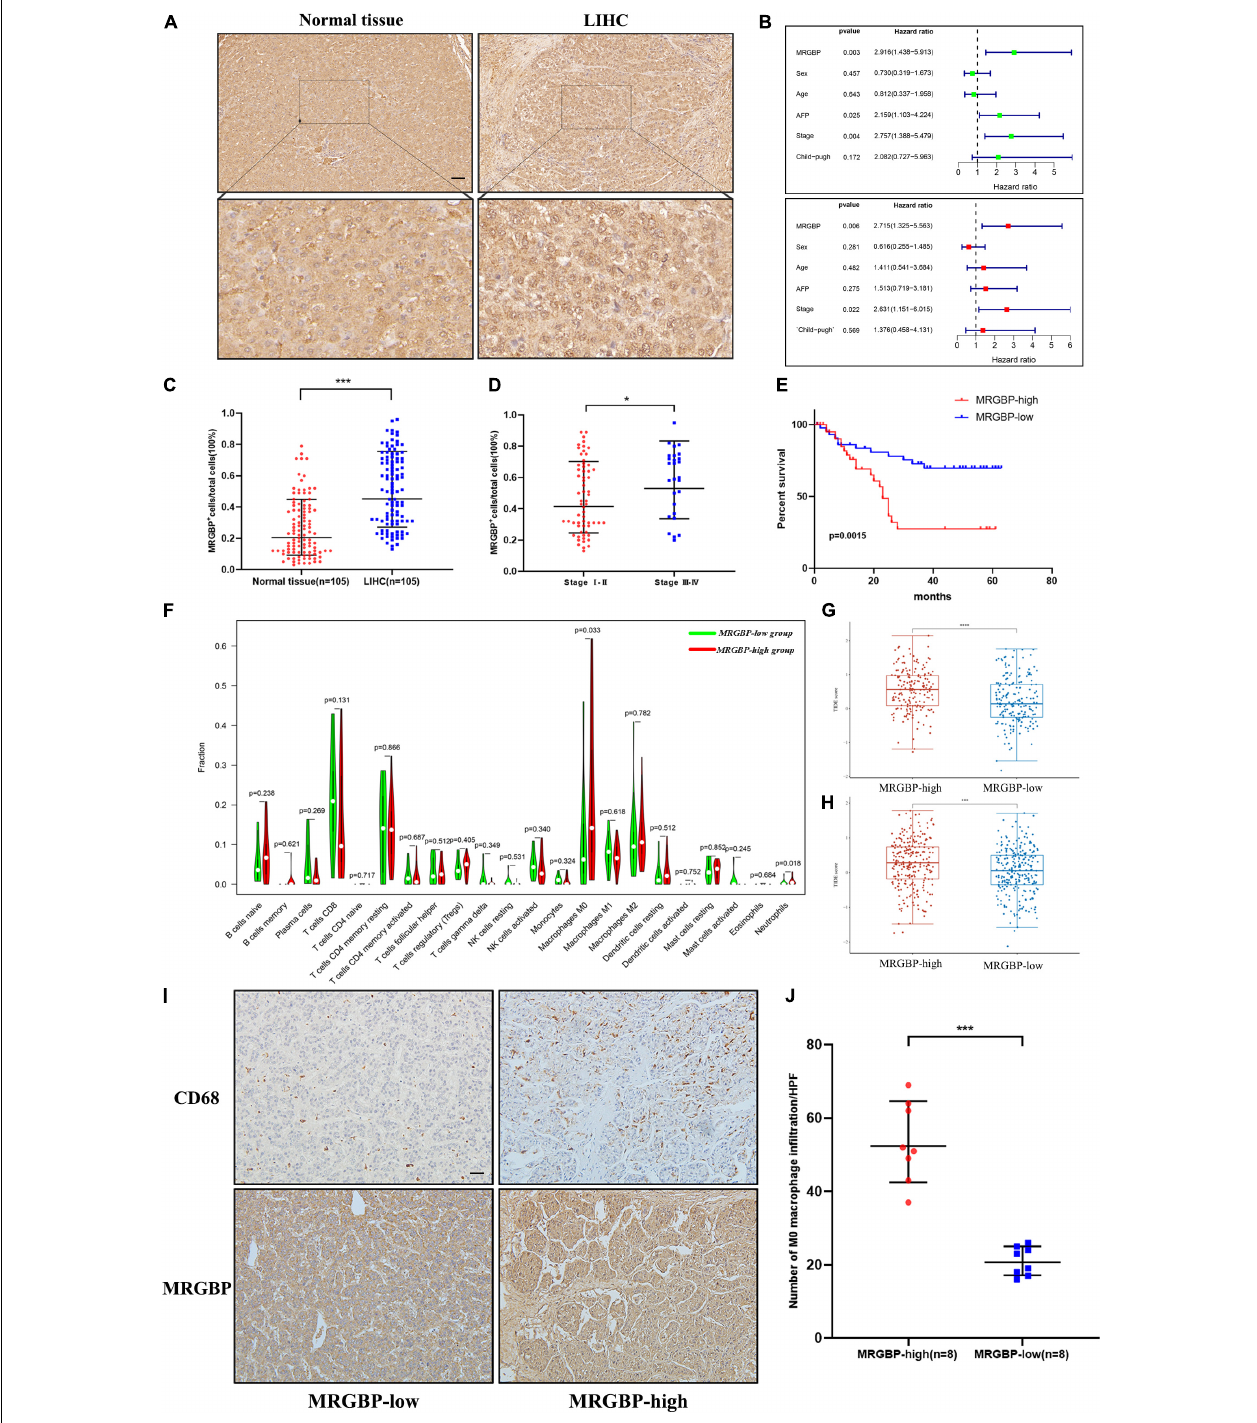
FIGURE 13 | Preliminary verification of MRGBP signature in LIHC. (A) Representative images of MRGBP immunohistochemistry in LIHC. The picture below shows the enlarged images. scale bars = 50 µ m. (B) Univariate and multivariate independent prognostic analysis of our LIHC data. (C) Quantification analysis showed higher MRGBP expression in LIHC. (D) . Quantification analysis showed higher MRGBP expression in stage III-IV patients. (E) Association between MRGBP expression and prognosis. (F) Relative abundance of tumor-infiltrating immune cells in the MRGBP low expression group vs. MRGBP high expression group. (G,H) TIDE scores in the high MRGBP and low MRGBP groups at LIHC and LGG. (I) Representative images of CD68 immunohistochemistry in the MRGBP low expression group and MRGBP high expression group. scale bars = 50 µ m. (J) Quantification analysis showed higher levels of M0 macrophage infiltration in the MRGBP high expression group (**** P < 0.0001, *** P < 0.001, * P < 0.05).